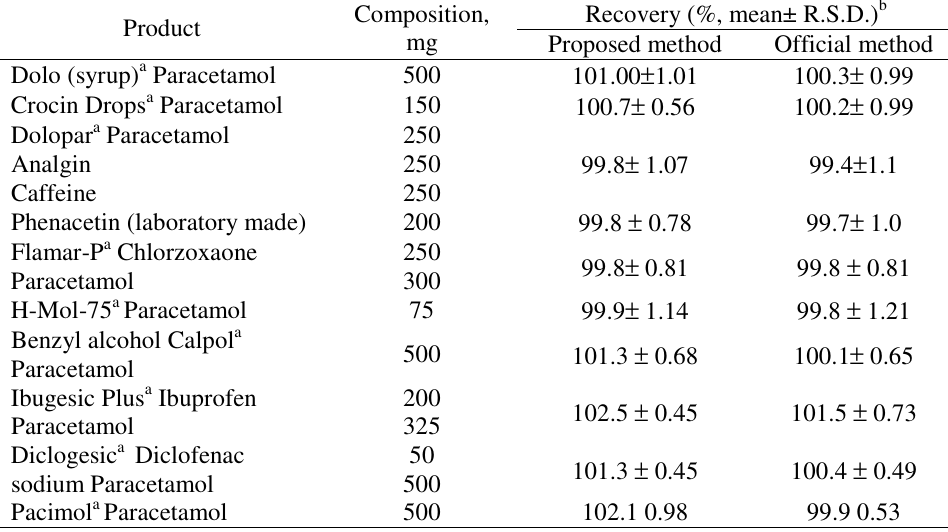
Table 3. Determination of paracetamol by the proposed method Recovery (%, mean± R.S.D.) b Composition, Product mg Proposed method Official method 500 101.00 ±